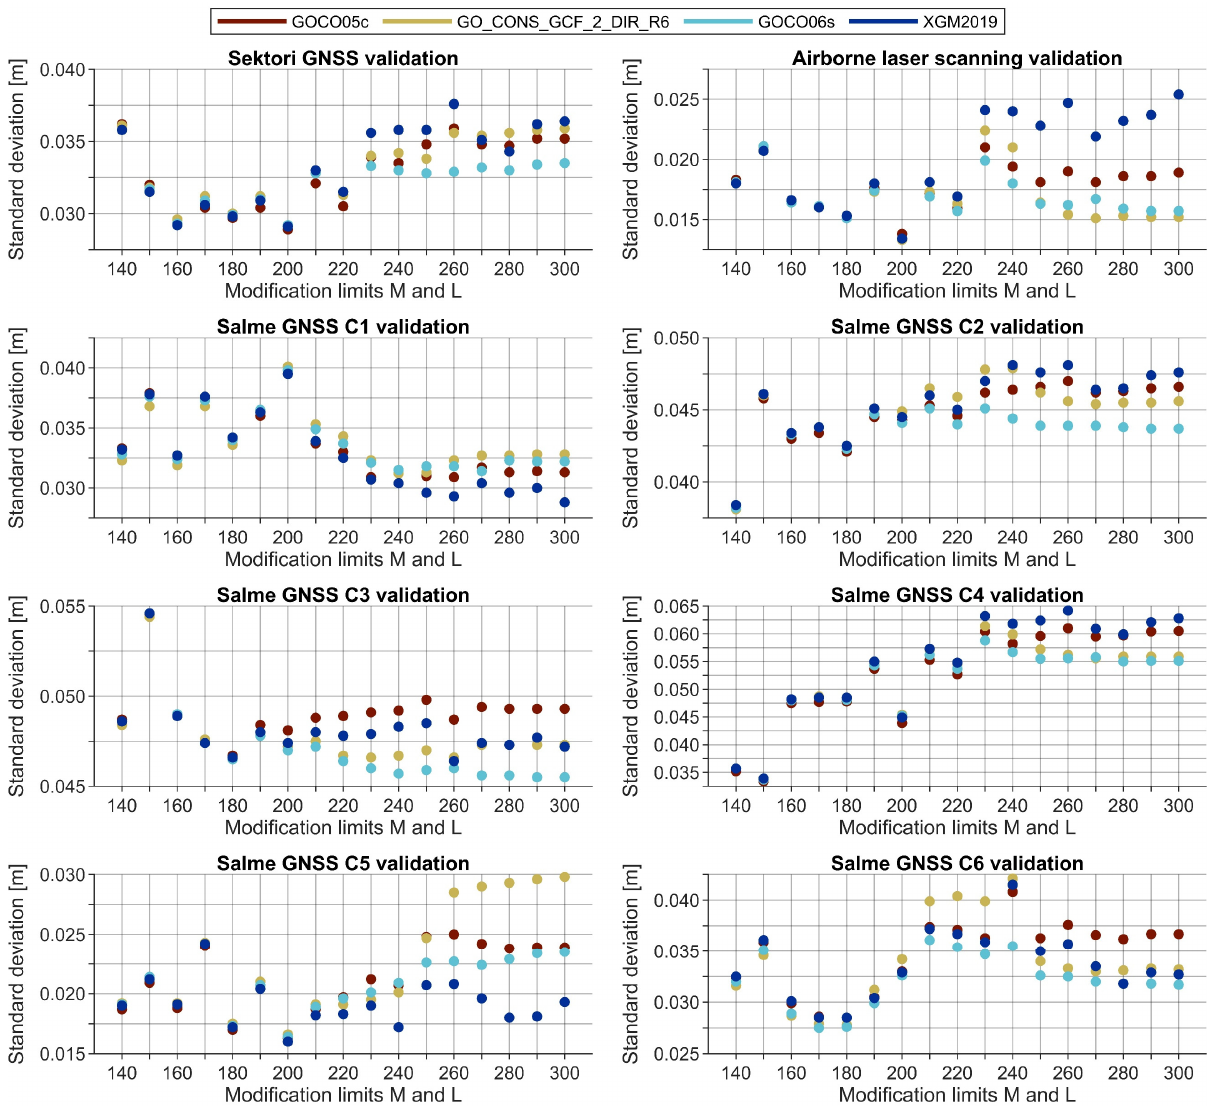
Figure 13. Validation results of gravimetric geoid models using shipborne GNSS-determined and airborne laser scanning-derived marine profiles of geoidal